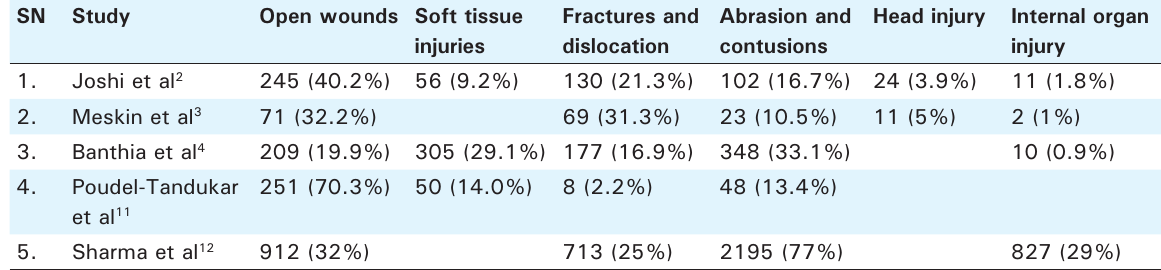
Table 4. Different forms of injuries sustained